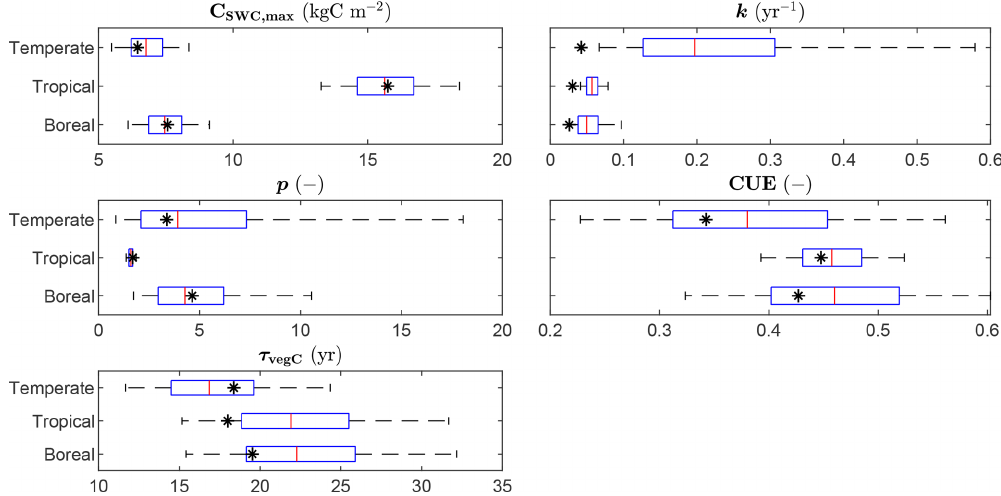
Figure 4. Ranges of the observations used in the calibration and LPJmL estimates after calibration. The box plots indicate the 5th and 95th percentiles (whiskers), the median (red line), and 25th and 75th percentiles (box) of the likelihood function. The fitted value is indicated by the asterisk ( ∗ ). C SWC , max : maximum stemwood C, k : growth rate; p : shape factor, CUE: carbon use efficiency (NPP-to-GPP ratio); τ vegC : vegetation C turnover time (vegetation-C-to-NPP ratio).